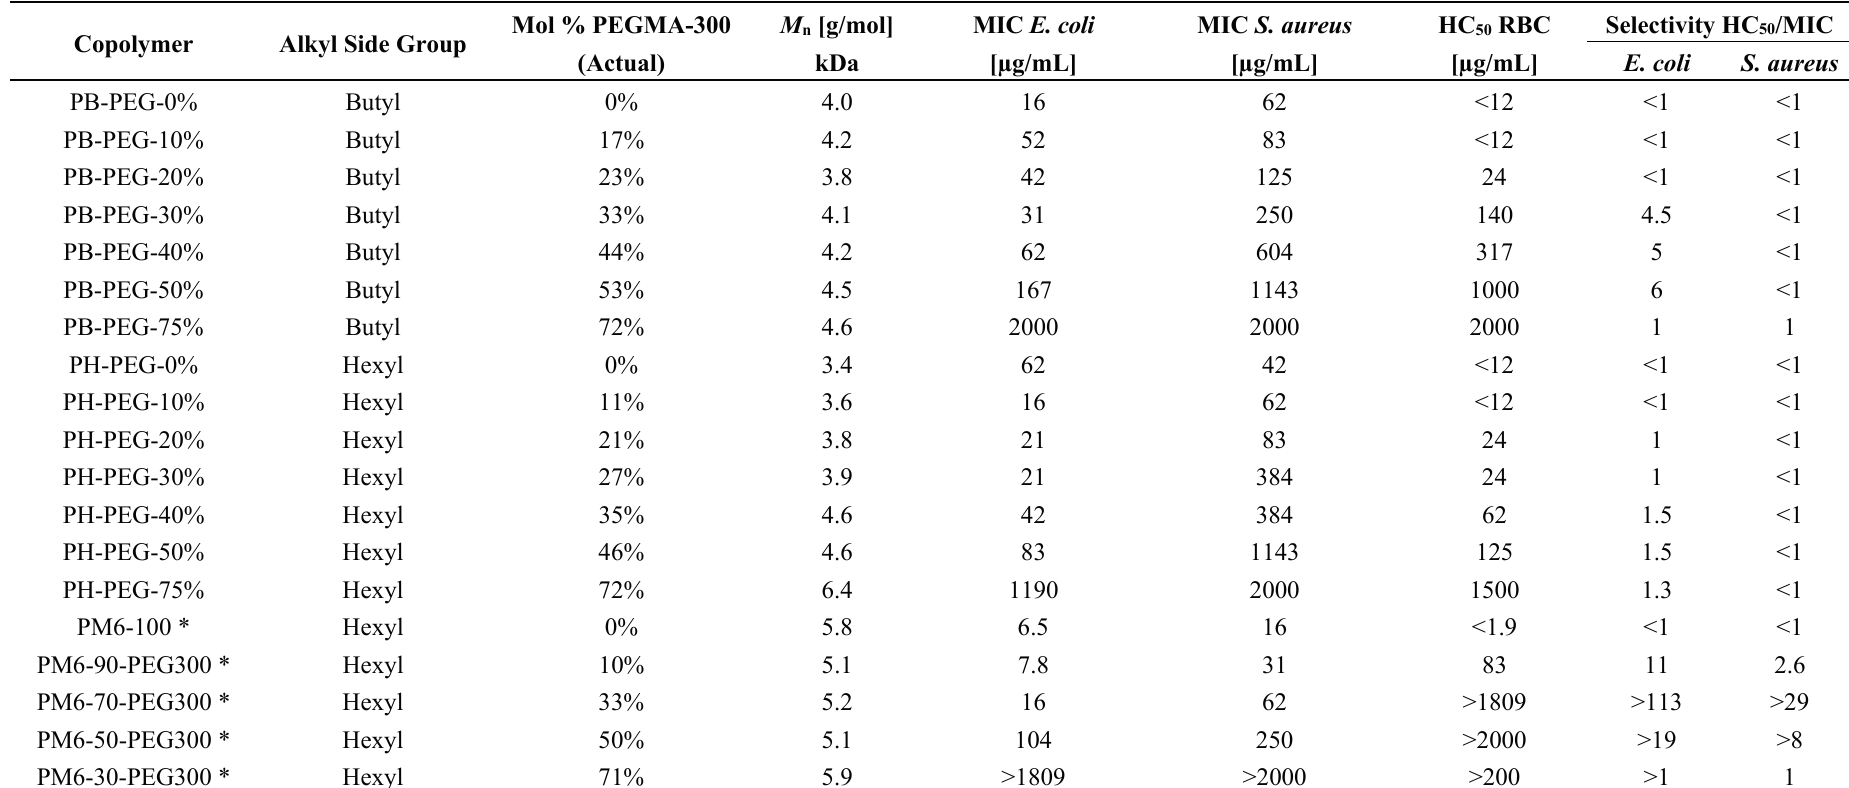
Table 1. Characterization and biological activities of amphiphilic